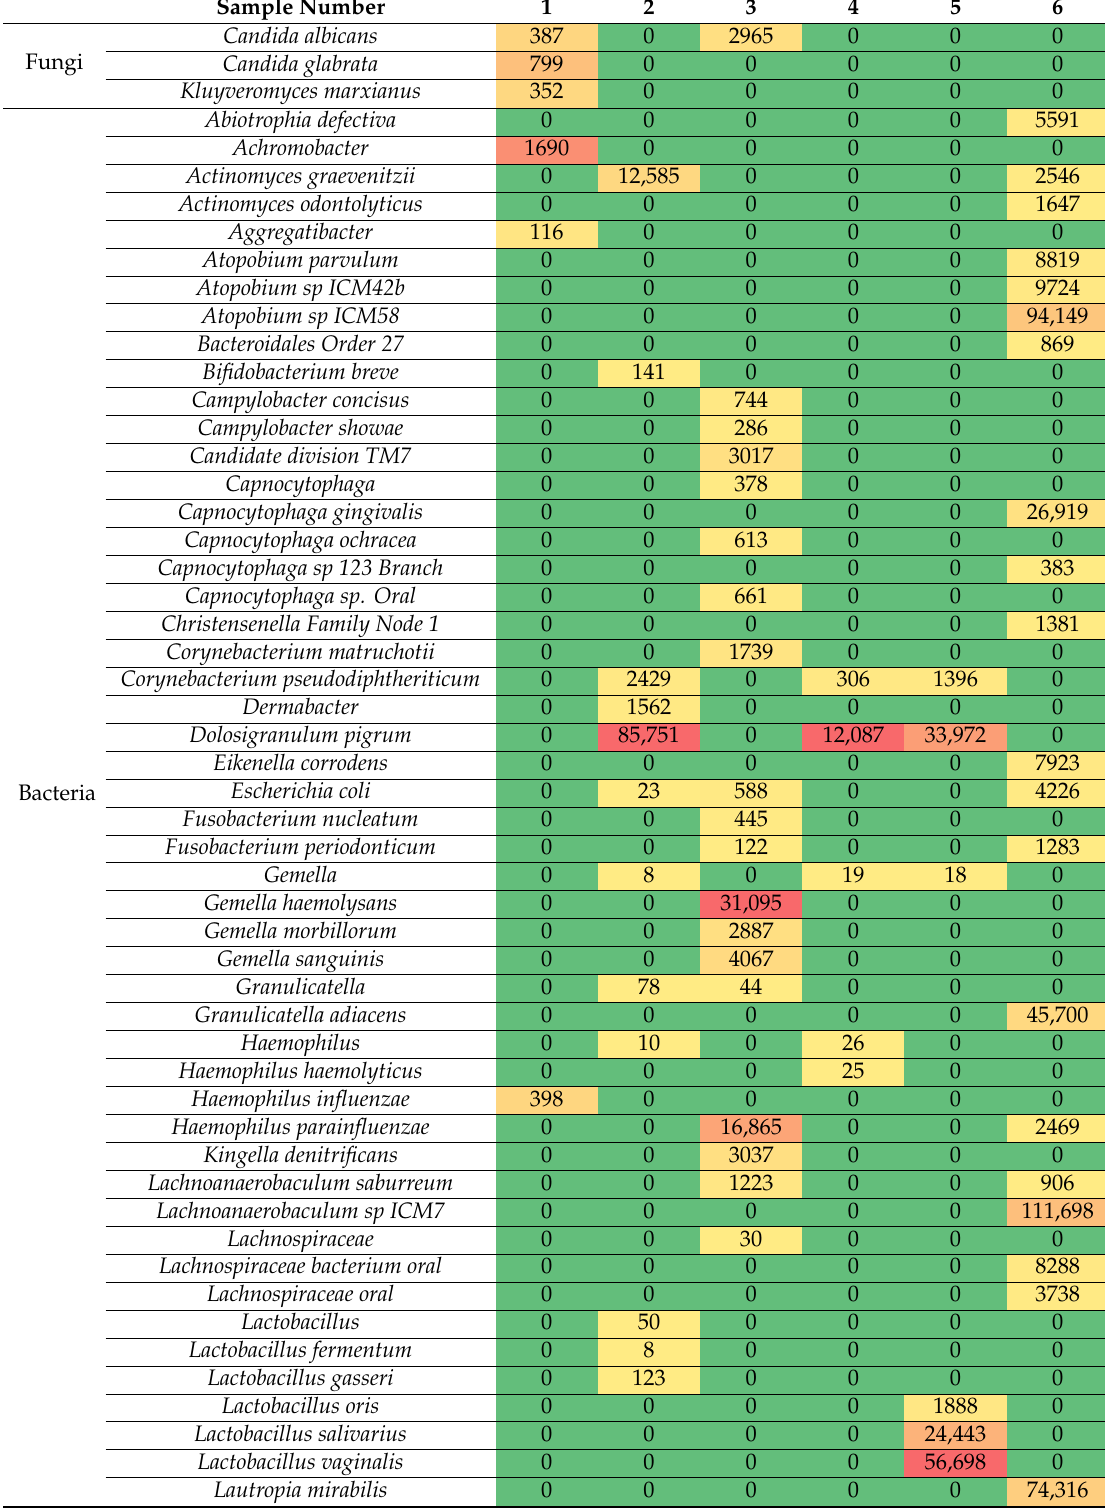
Table A3. Heat map for the filtered microbes in the studied clinical samples based on frequencies generated from the CosmosID